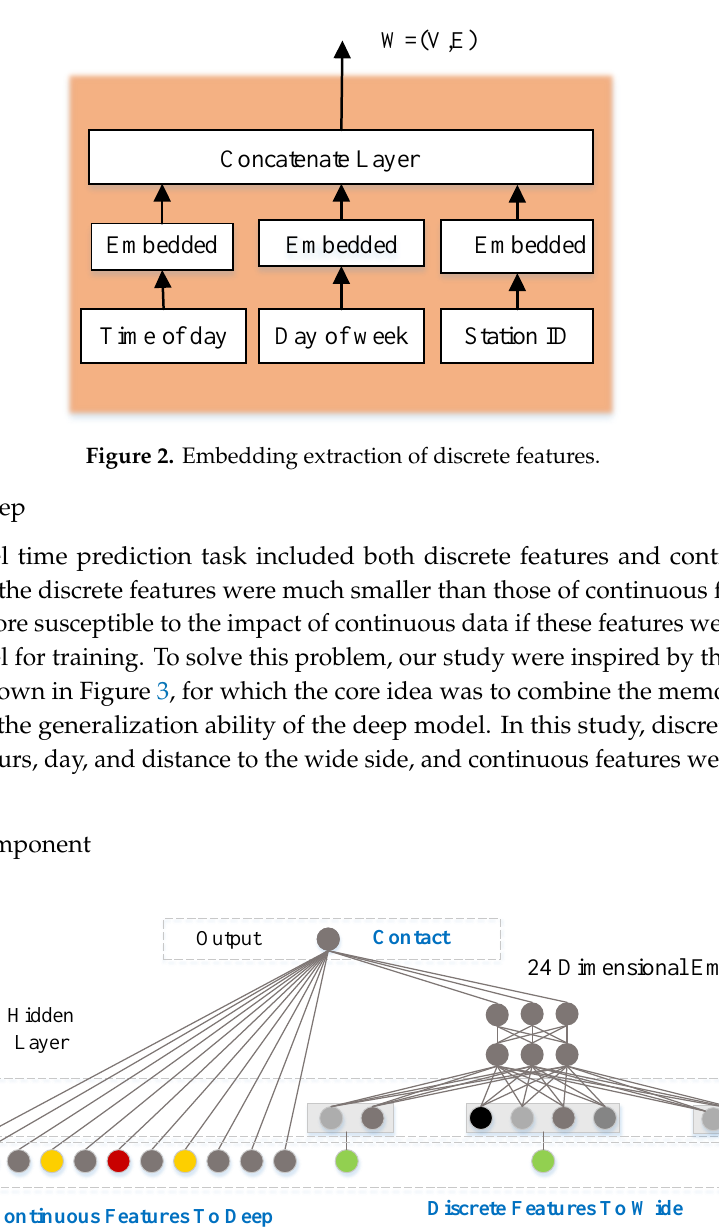
Figure 3. Illustration of the Wide and Deep model improved based on Cheng et al. (2016) [25].